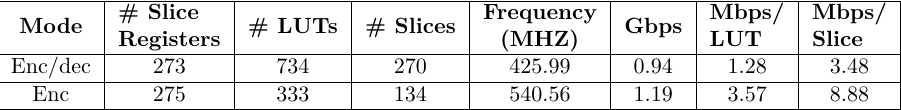
Table 3: TweGIFT-64 Implemented FPGA Results on Virtex 6